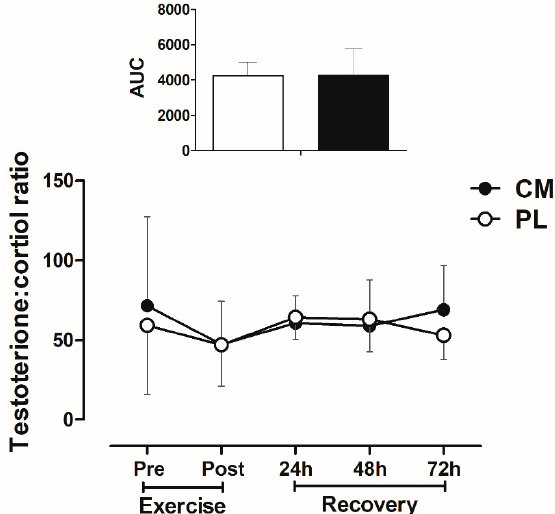
Figure 4. Serum testosterone:cortisol ratio at pre- and post-exercise, and immediately after fatigue tests during recovery (at 24, 48, and 72 h post-exercise). Citrulline malate (CM), Placebo (PL). Upper figure indicates the area under curve (AUC) from pre- to 72 h post-exercise. (Repeated-measures ANOVA: time p > 0.05; treatment × time p > 0.05). Data are means ± SD.